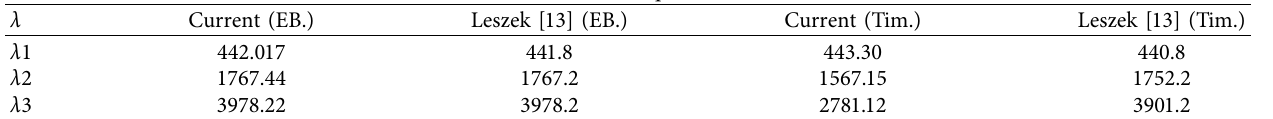
Table 6: First 3 natural frequencies for beam